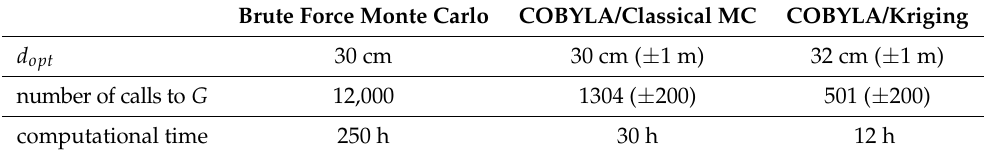
Figure 6. G function distribution: brute force analysis with F = [ 100 ± 25 ] MHz, heights and lengths varying. Table 2. Brute force, COBYLA/classical MC, and COBYLA/Kriging methods with F = [ 100 ± 25 ] MHz, heights and lengths